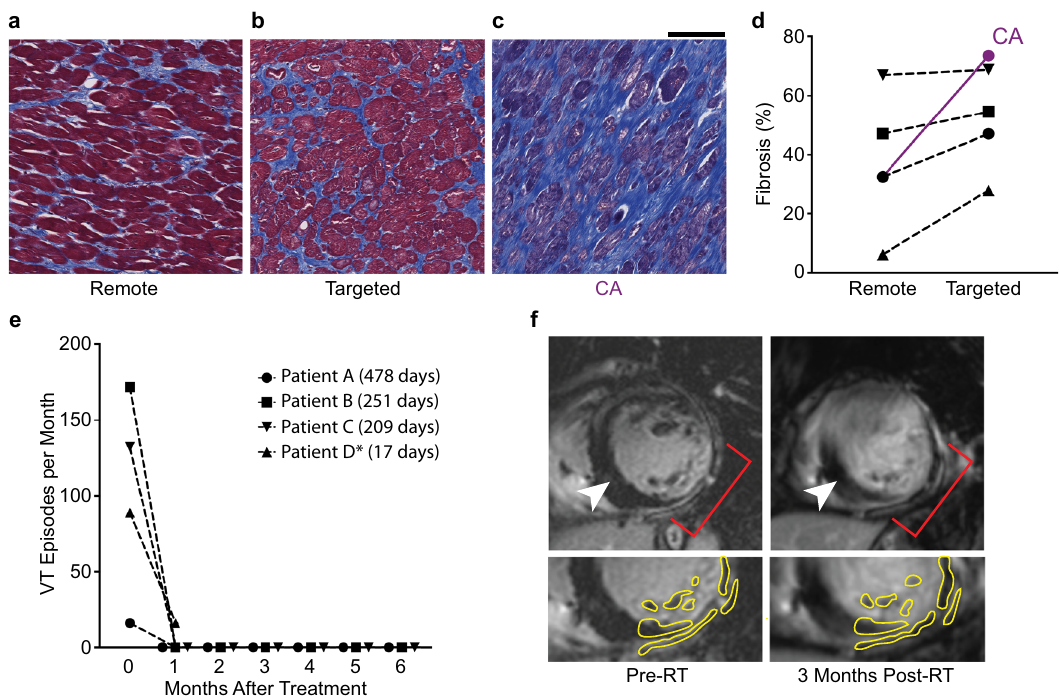
Fig. 1 Cardiac fi brosis alone cannot account for the timing and effect of VT reduction after RT. a – c Representative Masson ’ s trichrome stains of regions of remote ( a ), targeted ( b ), and failed CA ( c ) myocardium in the same patient who received 25 Gy ionizing radiation for treatment of refractory VT. Scale bars = 500 μ m. Experiment was independently repeated once on the same patient samples and produced similar results. d Percent fi brosis at the time of heart explant from 4 patients who received 25 Gy RT in control (left) and targeted (right) regions of myocardium. Percent fi brosis of the CA region for Patient A is shown in purple. e De fi brillator-recorded episodes of VT in the month before treatment and the 6 months after treatment for each patient. Days post-treatment until specimen collection are shown in the legend. *Patient D ’ s values are divided by 20 to allow for comparisons on the same scale. f Gadolinium-enhanced MRI of a cardiac RT patient at baseline (left) and 3 months post-treatment (right). Top: the left ventricle with patchy, gadolinium- enhanced scar was transmurally targeted with 25 Gy between 3 and 6 O ’ clock (red brackets). Nonenhanced, remote myocardium is adjacent to target region (white arrowhead). Bottom: surviving nonenhanced myocardium within the same images is visible in the targeted region at baseline and 3 months post-treatment (yellow outline). Source data are provided as a Source data fi